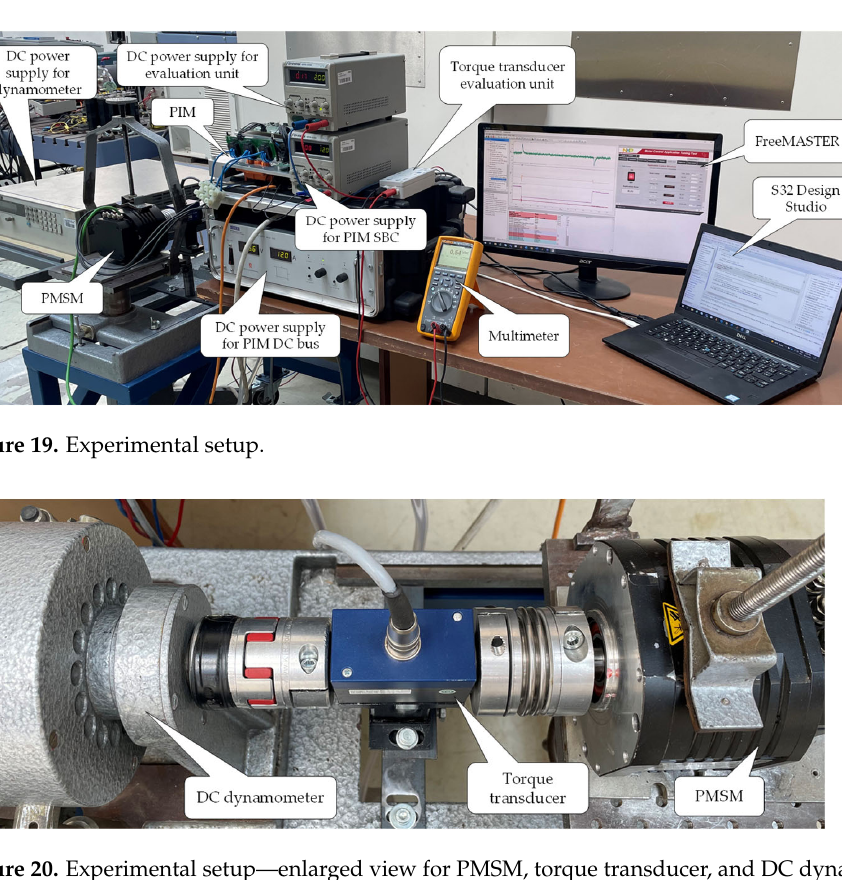
Figure 18. Required q v ‐ axis calculation block.